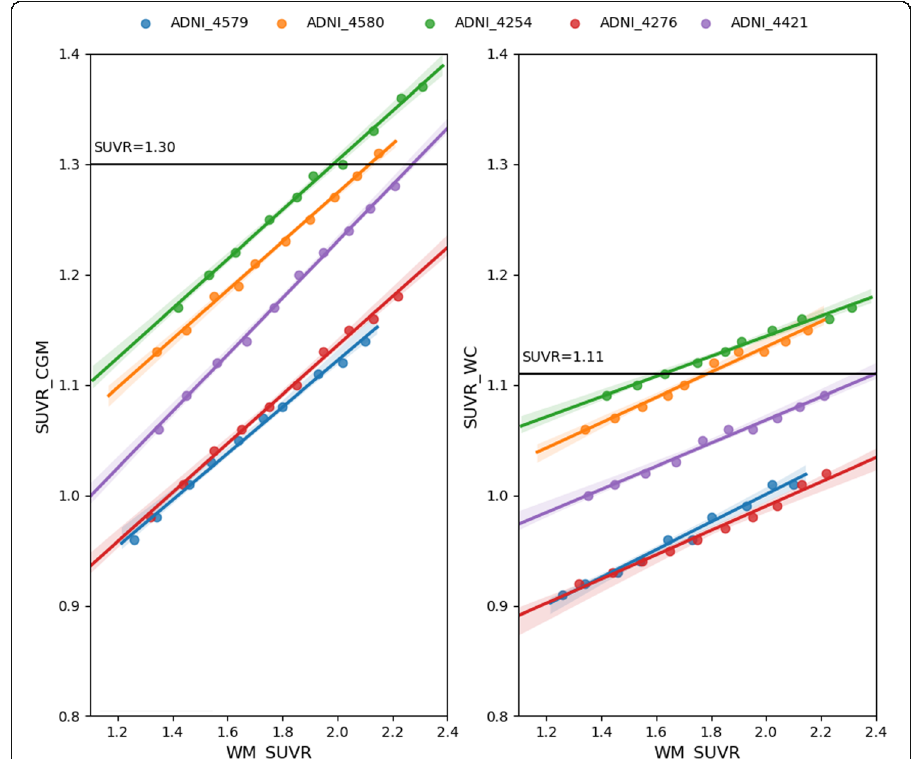
Fig. 5 Relation between the measured SUVRs and WM-SUVR CGM . Each color represents one of the simulated patients. Values were measured for SUVR CGM (left) and SUVR WC (right). Threshold values of SUVR CGM = 1.30 and SUVR WC = 1.11 are plotted for representation purposes